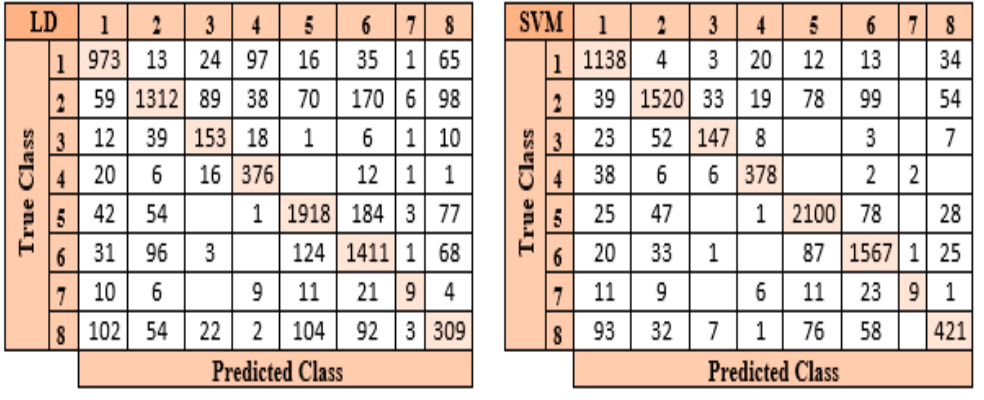
Table 4. Accuracy rate of LBP + mRMR (%).